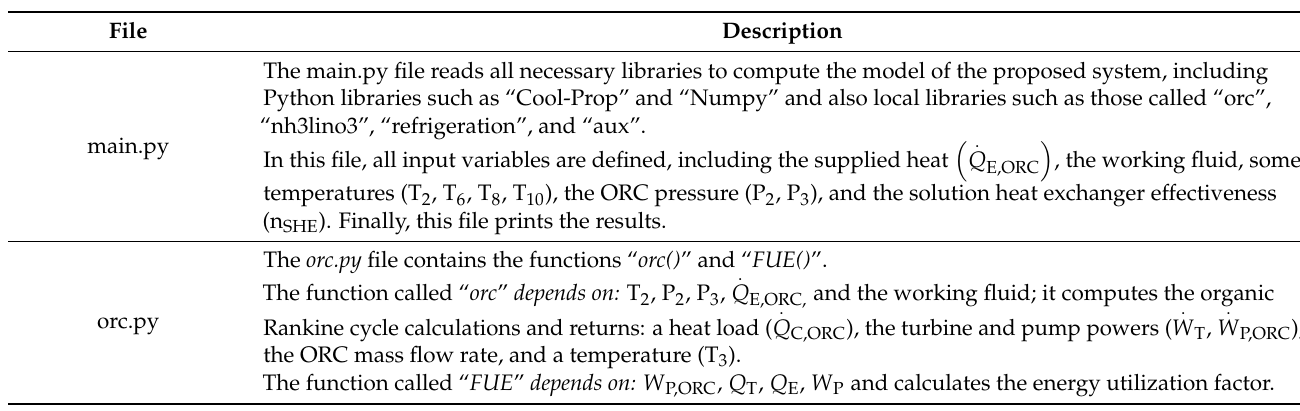
Table 5. Definition of the python files utilized to solve the numerical model of the proposed